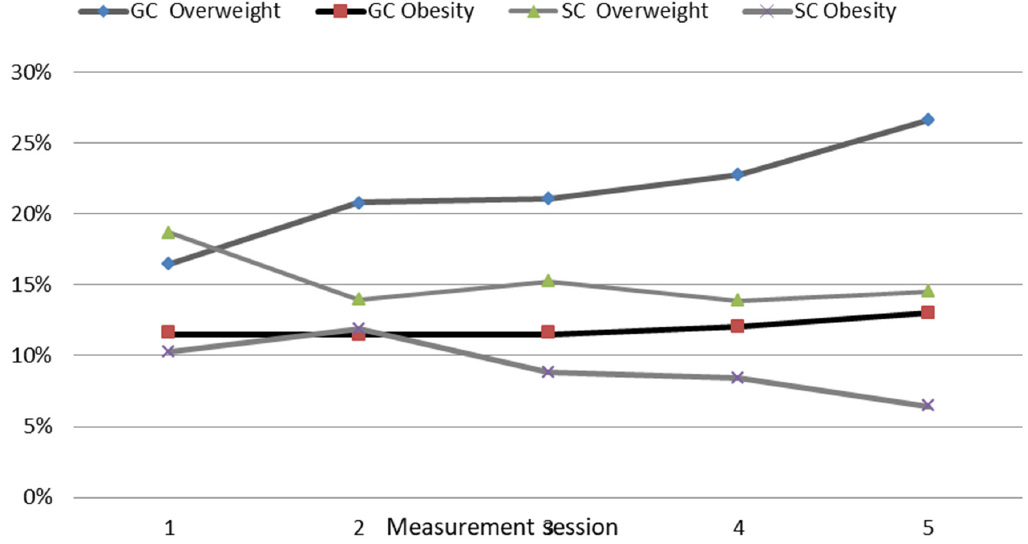
Figure 4. A comparison of the number of overweight and obese GC and SC children during the